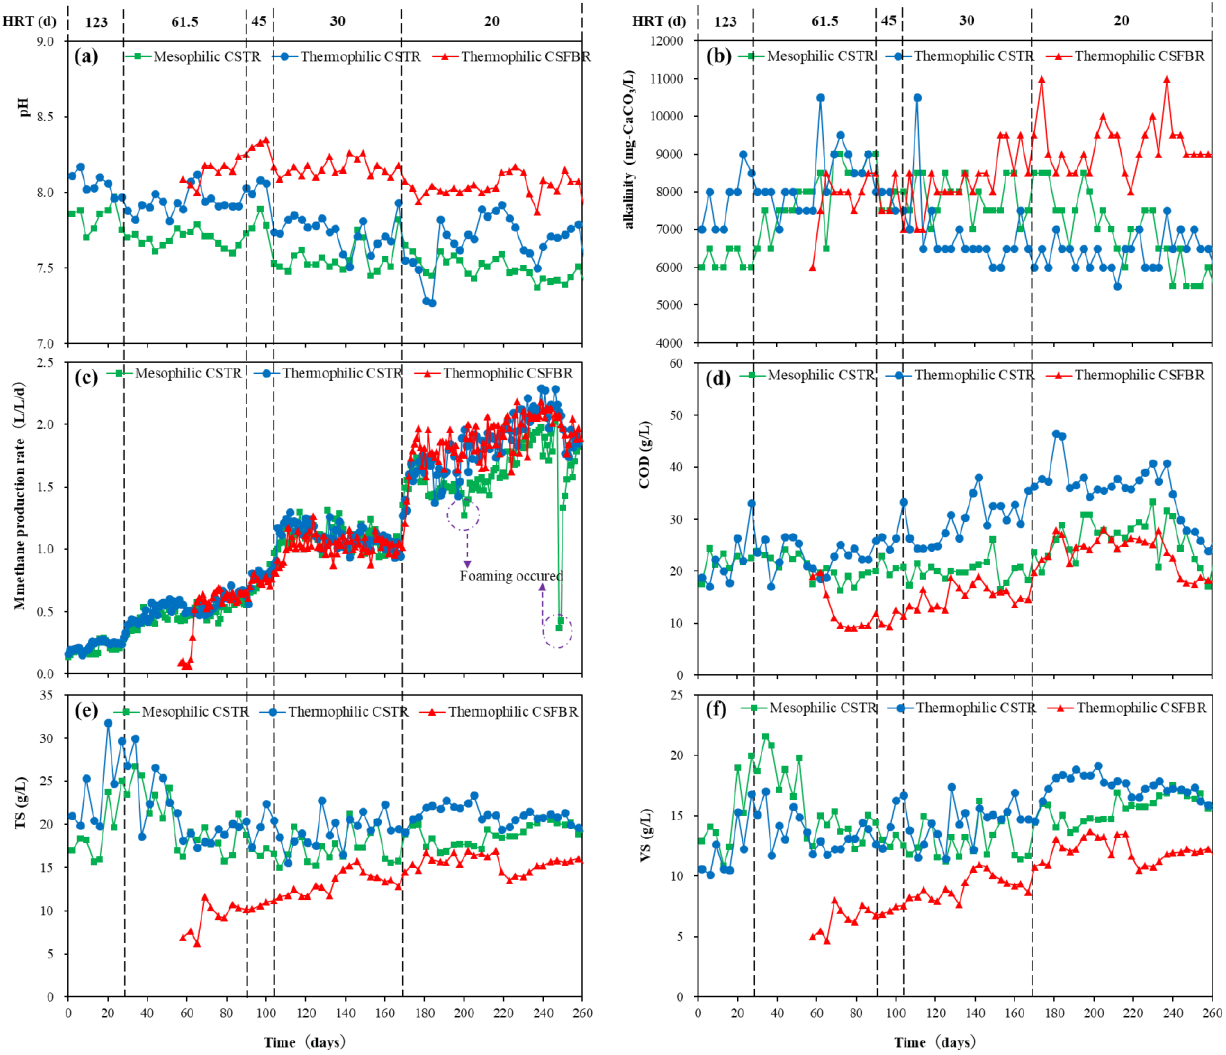
Figure 2. Overall performance of CSFBR and CSTRs.